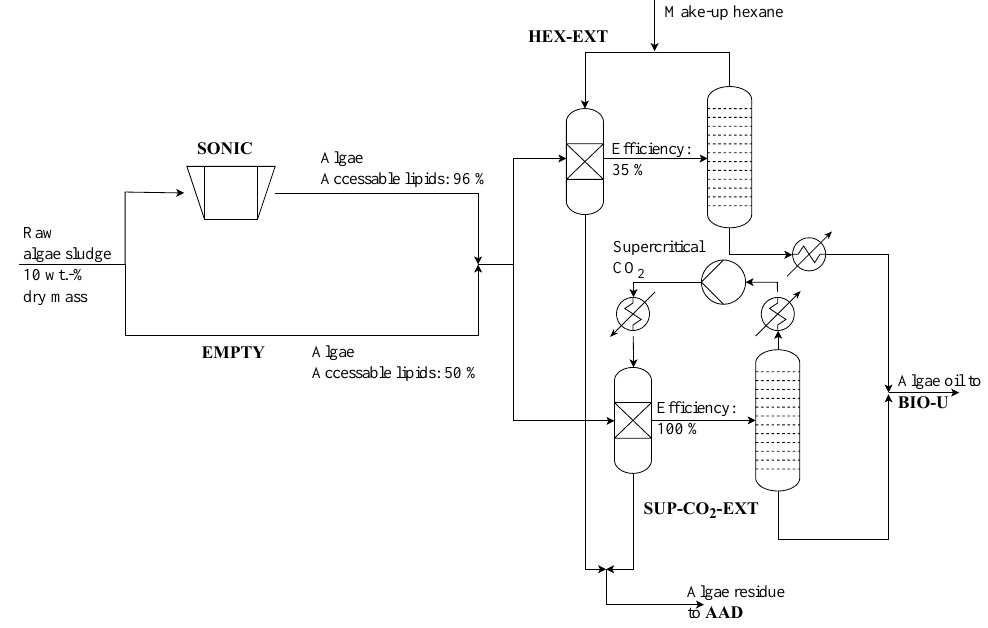
Figure 5. Algae pretreatment and lipid extraction process section of renewable refinery superstructure.